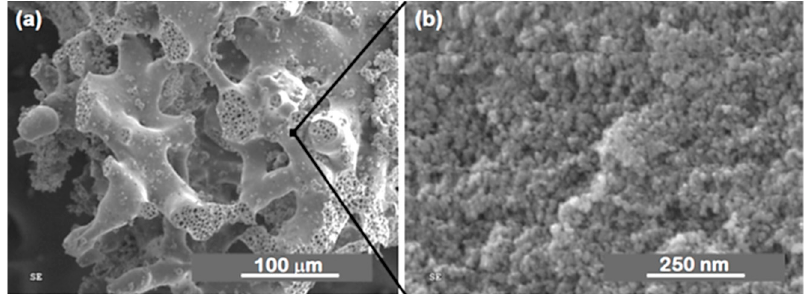
Figure 11. SEM photomicrographs of a heat-treated monolith of composition 70%SiO 2 –30%CaO (mol%), prepared by the sol-gel/phase separation technique with the addition of PEO: ( a ) magnification of 300× and ( b ) magnification of 120,000 ×. Reprinted by permission from Springer: Springer Nature, Journal of Materials Research, Sol-gel-derived glass scaffold with high pore interconnectivity and enhanced bioactivity, A.C. Marques, R.M. Almeida, A. Thiema, S. Wang, M.M. Falk and H.